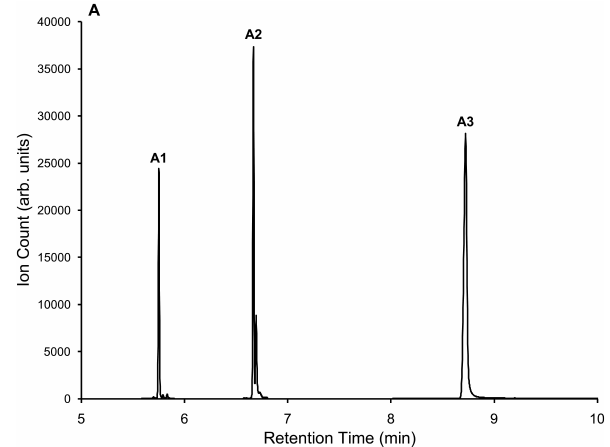
Fig. 4a. Chromatogram of X-NH 2 compound mixture in H 3 PO 3 derivatized with 2-furaldehyde analyzed by GC/MS. (A1) , hydrox- ylamine ( m/z 111, oxime); (A2) , methylhydrazine ( m/z 124, N - methylhydrazone); (A3) , hydrazine ( m/z 188, azine).